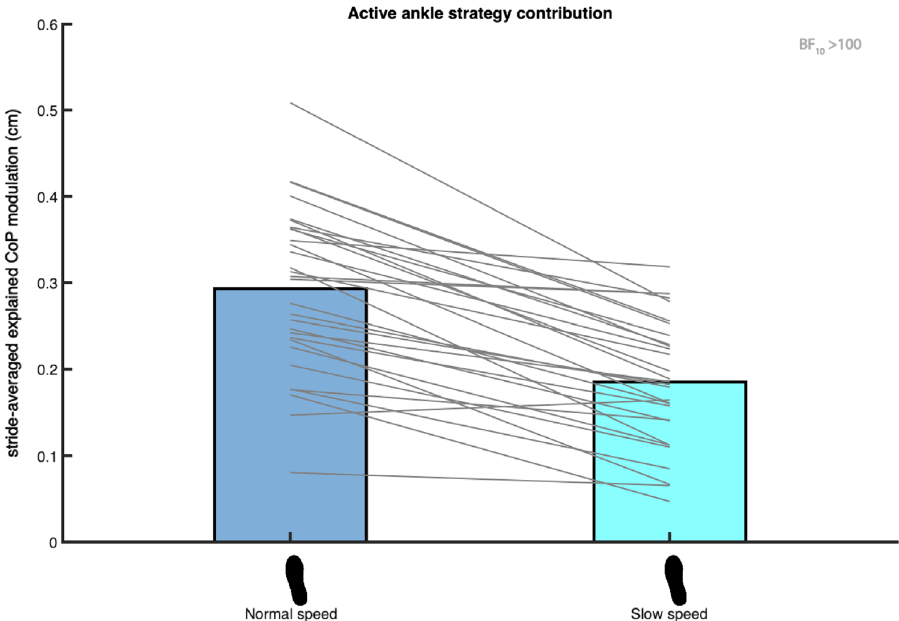
Figure 8. Mean absolute explained variance of the muscle model (3). Blue and light blue bars represent respectively the absolute explained variance at normal and slow walking speed. In this figure the absolute explained variance is expressed as the square root of the stride averaged explained variance, as a reflection of the magnitude of the average explained CoP shift in centimeters. The foot print represents the steady-state walking condition (see Table 1). The grey lines connect individual data points. The Bayes factor (BF 10 ) denotes the degree of evidence for a lower absolute explained variance at slow as compared to at normal walking speed. This figure was created using Matlab 2021a (https:// www. mathw orks. com/ produ cts/ matlab. html) and Adobe Illustrator CC 2018 (https:// www. adobe. com/ nl/ produ cts/ illus trator.